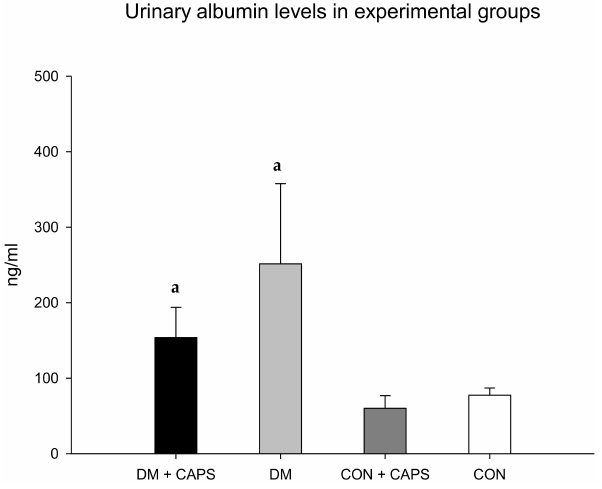
Figure 2. Effect of 8 weeks of capsaicin administration (1 mg/kg/day) on urinary albumin levels. ( a ) Statistically significant difference in comparison with the CON healthy group + CAPS. Data are mean ± SEM.